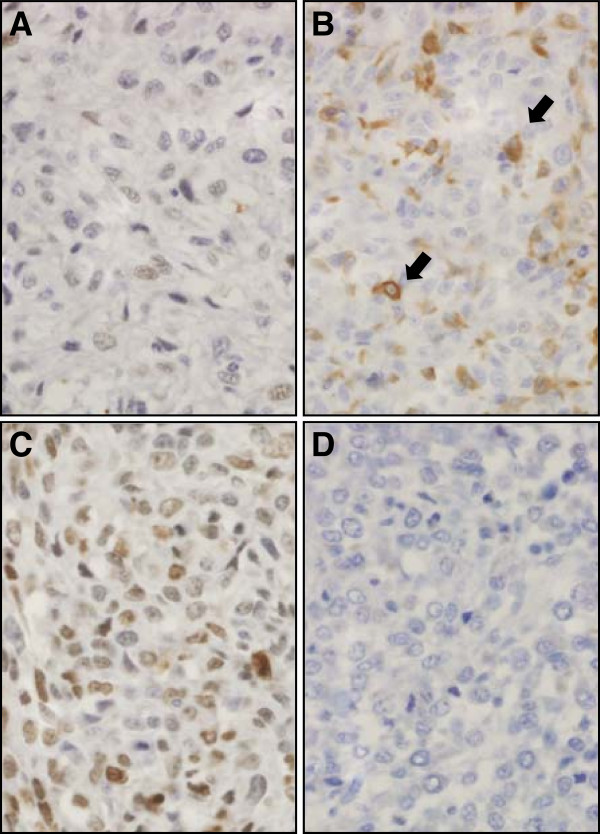
Immunohistochemical analysis of nuclear HES1 protein expression in canine osteosarcoma. Examples of low (A and B, score 2) and high (C, score 6) nuclear HES1 expression in canine osteosarcomas (D is a negative control treated only with secondary antibody). Panel B shows example of a field from a low scoring tumor (based on nuclear staining) that includes scattered strong cytoplasmic staining (arrows). All photomicrographs were taken at 40× magnification; haematoxylin counterstain.